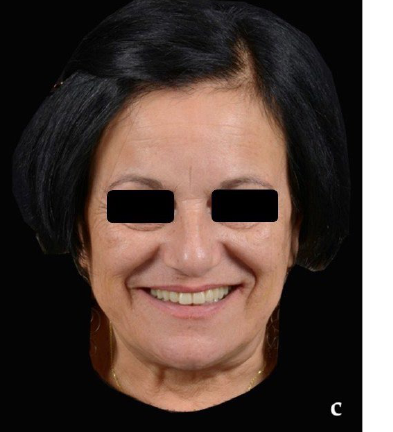
Figure 12. Provisional prosthesis positioning ( a ), post-surgical orthopantomography ( b ) and final extraoral aspect of the patient ( c ).